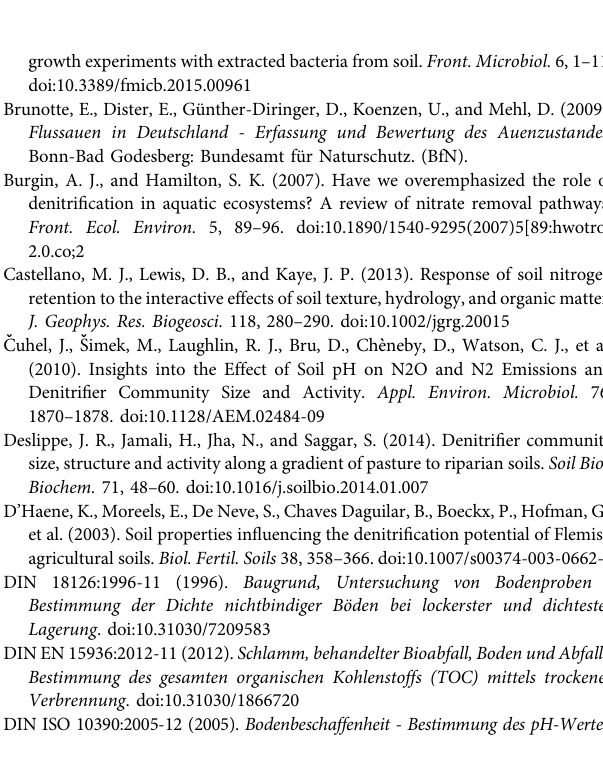
Supplementary Figure 1 | River water level in the study areas Elbe_R (ER), Elbe_S (ES), Weser_S (WS), Main_U (MU), Rhine_E (RE), Rhine_K (RK) in the sampling year 2017 (black line), mean river water level of the last 5 years (medium gray line), and interquartile range (iqr) with mean river water level in the long term of 30 years (light gray patch and line). Dashed lines mark the period of soil